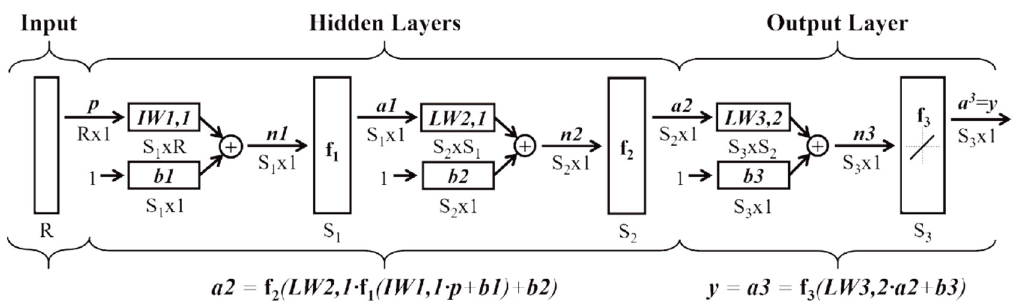
Figure 3. Representation of a three-layer feedforward neural network.